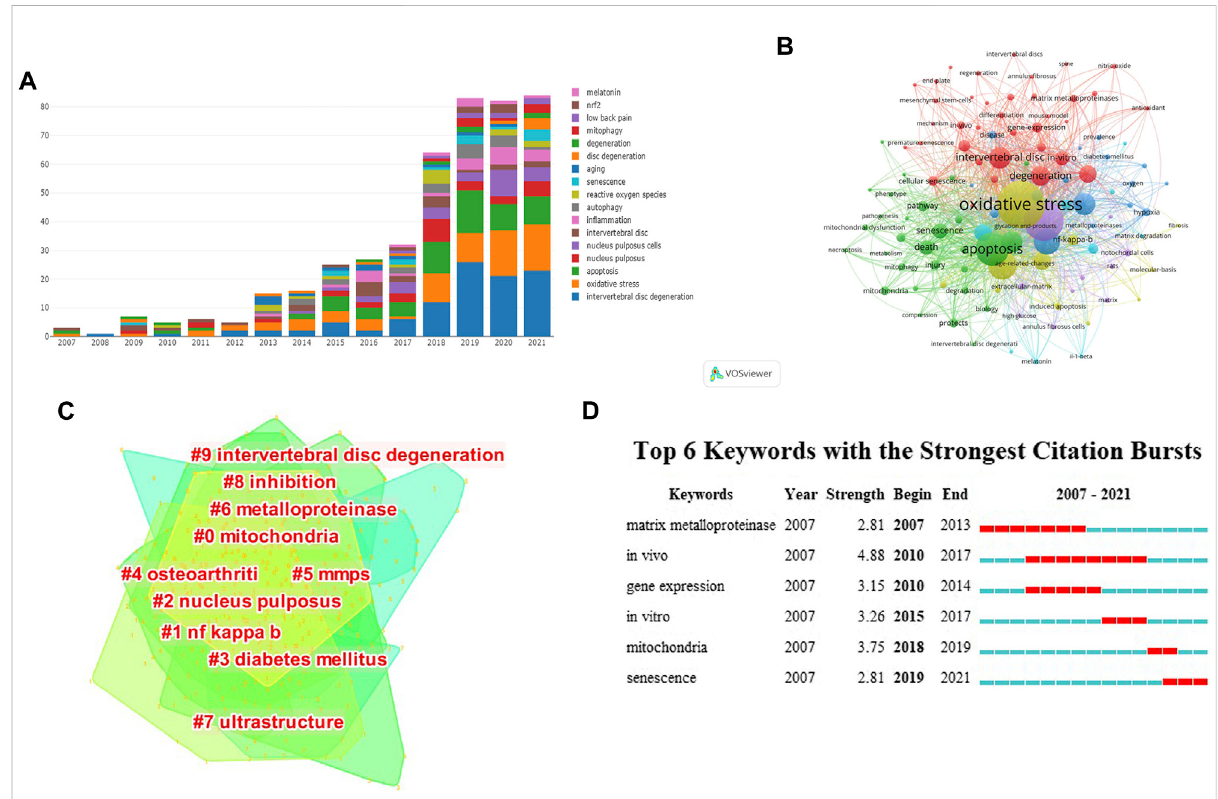
FIGURE 7 (A) The distribution of the bibliographic keywords per year of the top ten countries on oxidative stress in intervertebral disc degeneration. (B) Keywords co-occurrence visualization on oxidative stress in intervertebral disc degeneration. (C) Key words clusters on oxidative stress in intervertebral disc degeneration. (D) Top six keywords with the strongest citation bursts on oxidative stress in intervertebral disc degeneration. (A point in the fi gure represents a keyword. The color of the point represents different clusters, and the size of the point represents the co- occurrence for each keyword. The more the co-occurrence, the larger the point; # represents different cluster labels, #0 mitochondria, #1 NF- kappa b, #2 nucleus pulposus; #3 diabetes mellitus, #4 Osteoarthriti, #5 MMPS; #6 metalloproteinase, #7 ultrastructure, #8 inhibition; #9 intervertebral disc